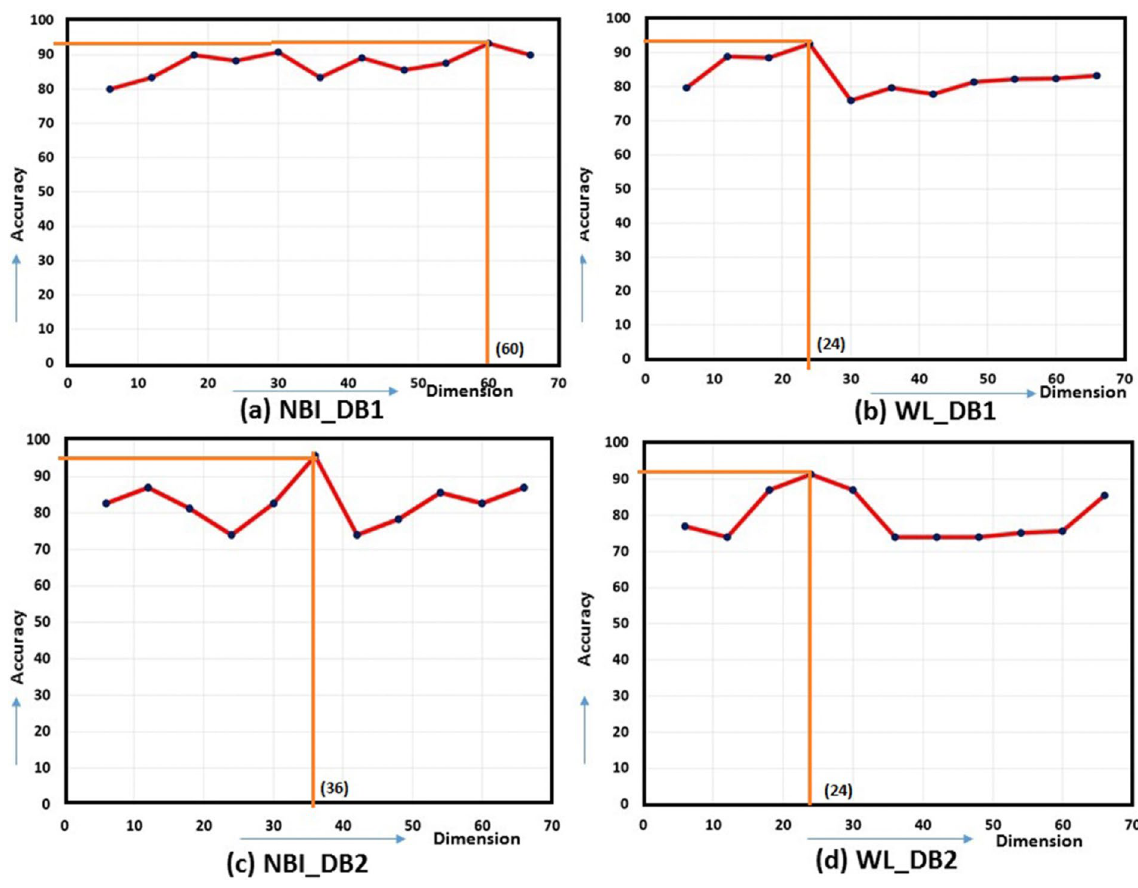
Figure 7. Feature selection in NSCT.